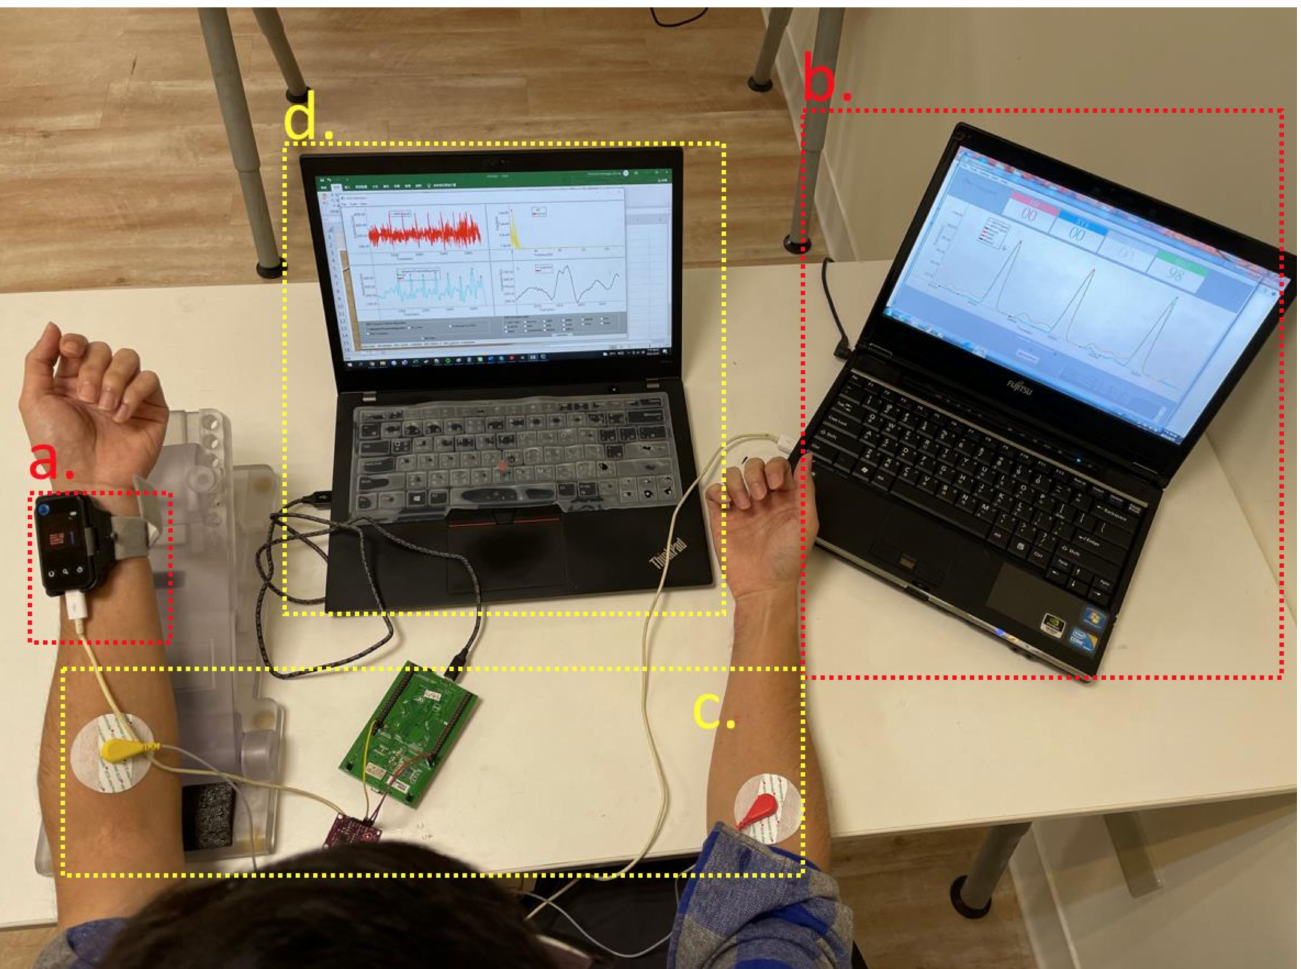
Figure 9. ( a ) Pulse wave measurement device. ( b ) USB data acquisition system. ( c ) ECG measurement device and limb lead. ( d ) ECG signal acquisition